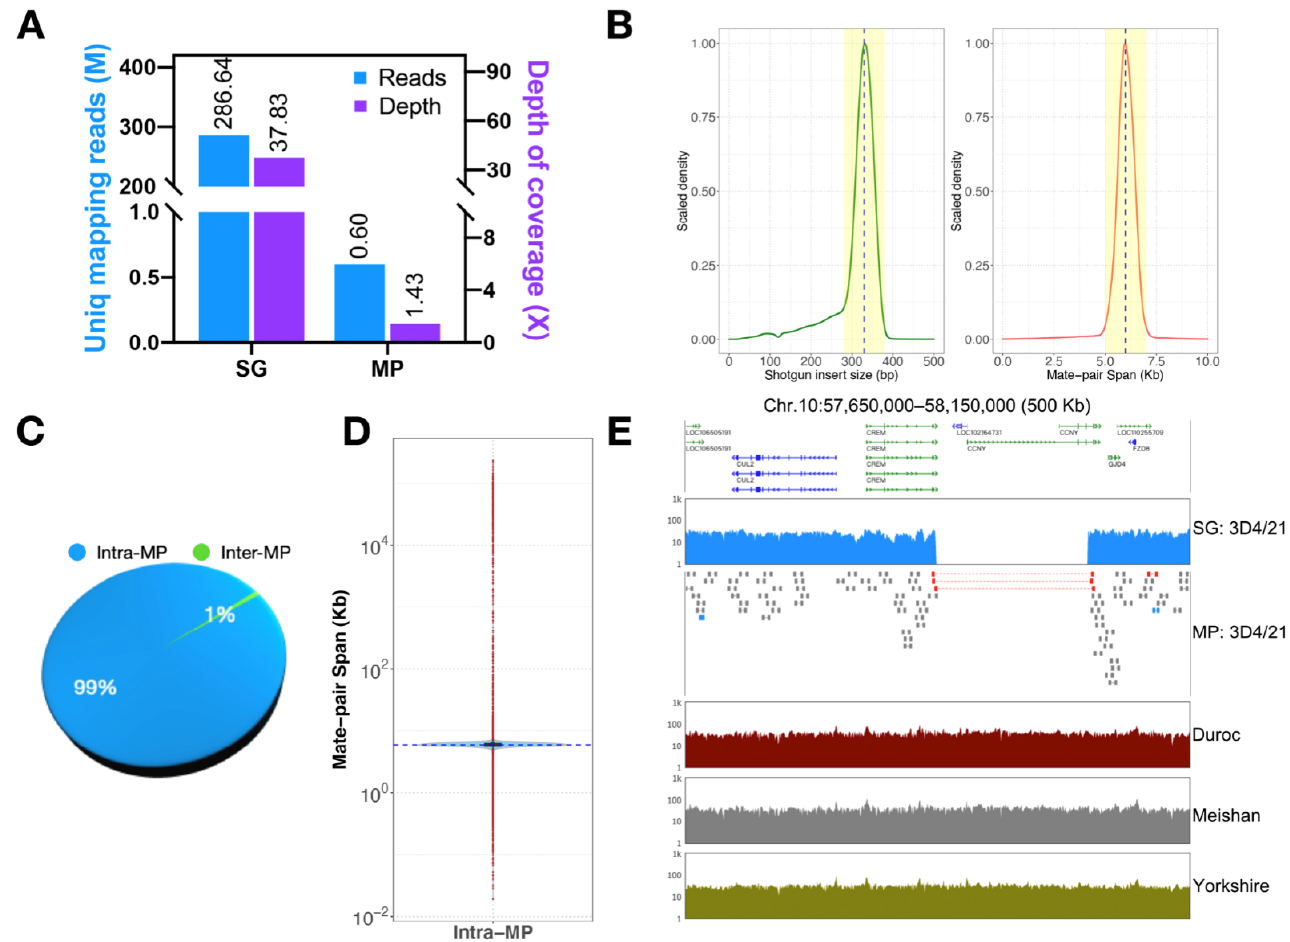
Figure 2. Characterization of All-Seq library of porcine macrophages (3D4/21). ( A ) The histogram shows the unique mapping reads and depth of coverage of Shotgun and Mate-pair. Blue means unique mapping reads, and purple means depth of coverage. ( B ) The scaled density plot shows the size distribution of Shotgun (left), where the dotted line represents the median 330 bp and the yellow shadow represents the median distance ±50 bp, and the span distribution of Mate-pair (right), where the dotted line represents the median 6 kb and the yellow shadow represents the median distance ±1 kb. ( C ) Pie chart showing the proportion of Intra/Inter Mate-pair. Intra-MP in blue and Inter-MP in green. ( D ) Violin plots depicting the span distribution of Intra Mate-pair. The blue highlight indicates that if the normal MP size ranges from 4.8 kb to 7.2 kb. If (Q1 − 1.5 × IQR) < 4800 bp it is defined as insertion, and if (Q3 + 1.5 × IQR) > 7200 bp it is defined as deletion. ( E ) Visual integration showing 3D4/21 cells specific structural variation on Chr.10: 57,650,000–58,150,000. Red in MP means deletion and blue means insertion. The data tracks from top to bottom show the Shotgun and Mate-pair of 3D4/21 cells, the Shotgun of Duroc, Meishan, and